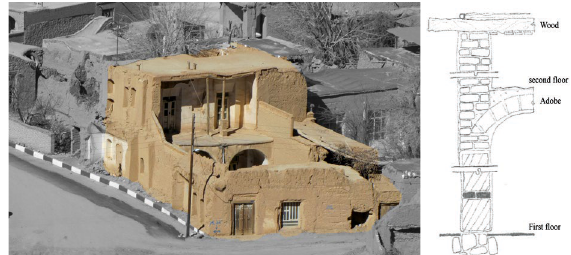
Figure 13. The wall section of one examples of study houses in the third era,